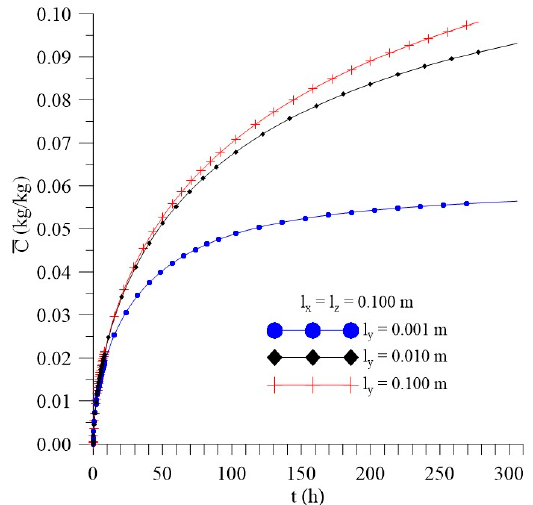
Figure 21. Kinetics of the average free solute concentration for different distances l y (Cases 9, 11, and 12).